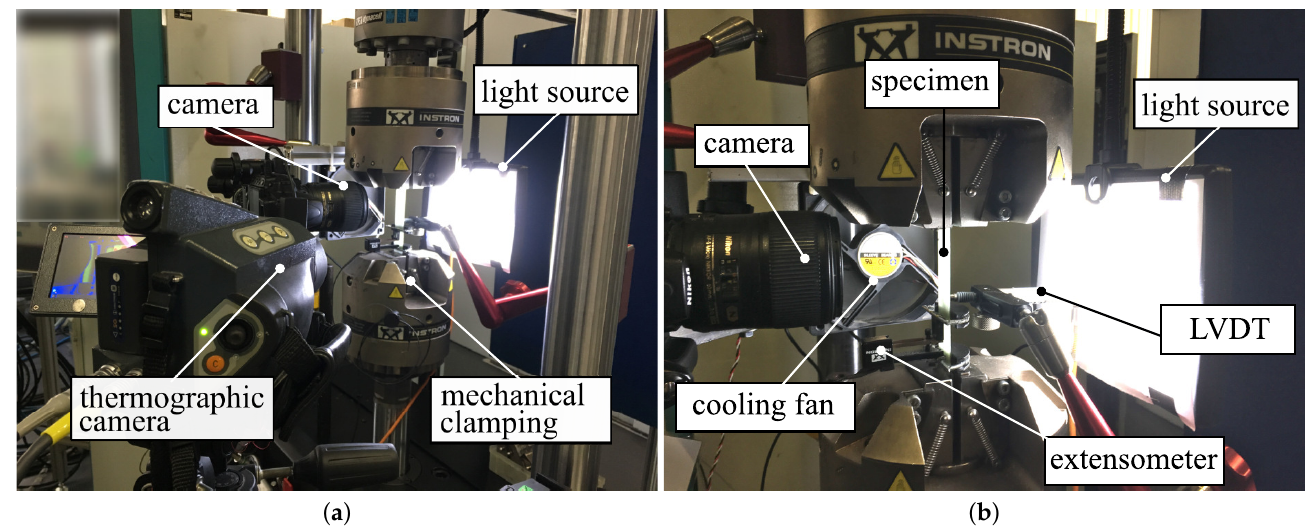
Figure 2. Experimental setup used for crack analysis in static and fatigue loading: ( a ) complete setup and ( b ) detail of the specimen and measuring